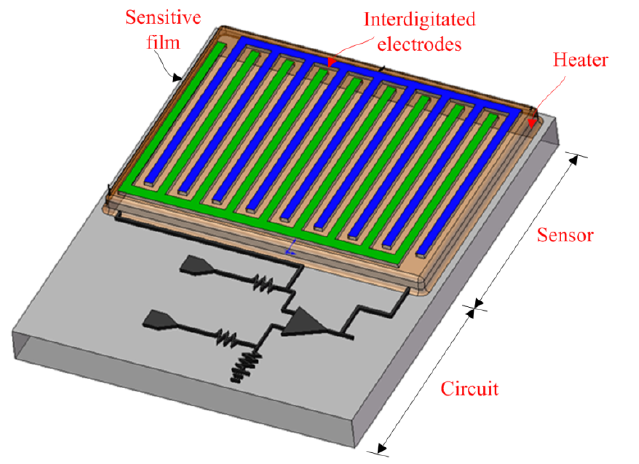
Figure 1. Schematic of the integrated ammonia sensor.